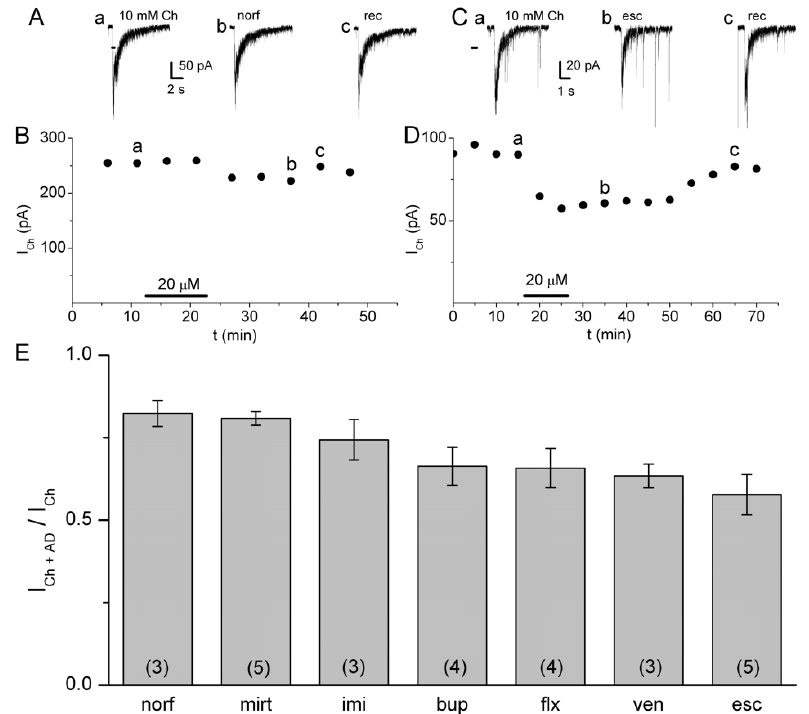
Figure 2. Samples of the current elicited by choline (I Ch ) recorded in interneurons from the stratum radiatum rat hippocampal CA1 region and inhibited by 20 µ M norfluoxetine ( A , B ) and 20 µ M escitalopram ( C , D ) as a function of time. Data labeled as a , b , and c in ( B , D ) correspond to upper records in ( A , C ): control ( a ), maximal inhibited ( b ), and recovered ( c ) I Ch . ( E ) The height of the columns corresponds to the ratio I Ch+AD /I Ch for each antidepressant at 20 µ M. I Ch+AD corresponds to the I Ch in the presence of the corresponding antidepressant. From left to right: norf, norfluoxetine. mirt, mirtazapine. imi, imipramine. bup, bupropion. flx, fluoxetine. ven, venlafaxine. esc, escitalopram. Data correspond to the mean ± standard error. The number of independent experiments is in parenthesis. Comparison of the experimental data with their own control means was performed by paired Student’s t -test. p < 0.05 was considered statistically significant for all the antidepressants. The nonparametric Kruskal – Wallis test resulted in significant differences between different groups. The Mann Whitney Wilcoxon Post hoc analysis revealed no significant differences between pairs of groups.